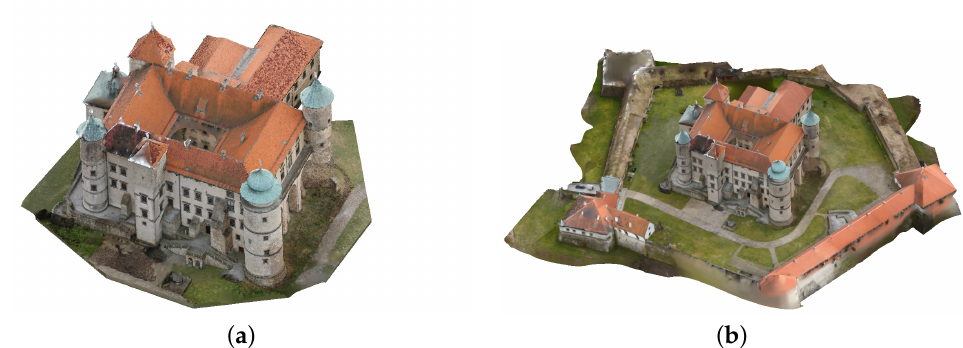
Figure 12. Polygonal models of the castle in Nowy Wi´snicz: ( a ) building only (4,133,352 faces), ( b ) the building with fortifications (1,966,487 faces).